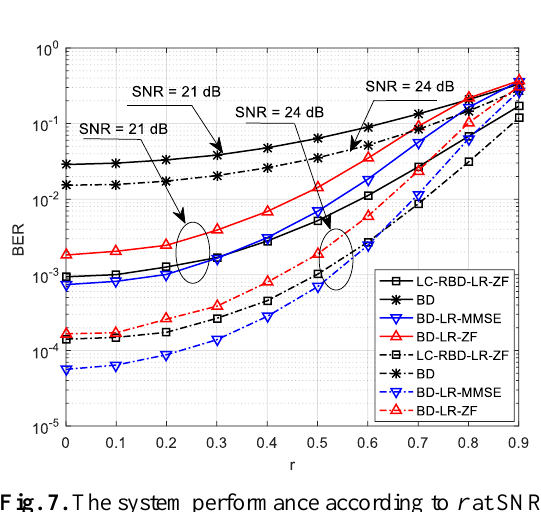
Fig. 6. The system performance with = 4 in the case of correlated channel use the exponential correlation channel model, r = 0.5 and r = 0.7